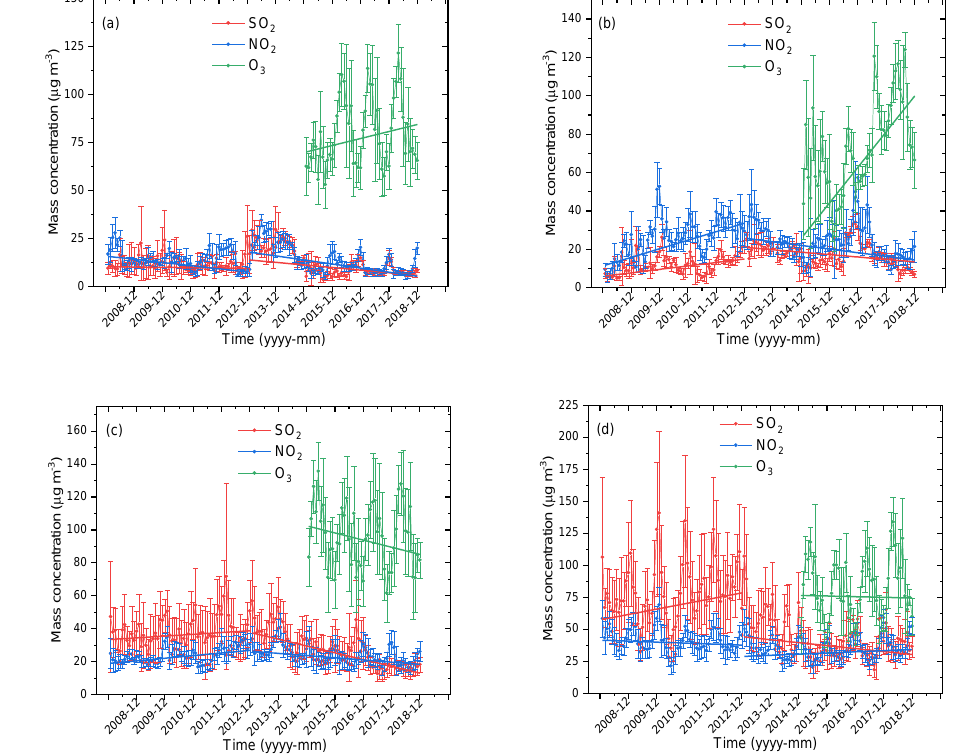
Figure 2. Variations of monthly mean mass concentrations of SO 2 , NO 2 , and O 3 in ( a ) Aba, ( b ) Ganzi, ( c ) Liangshan, and ( d ) Panzhihua from 2008 to 2018.